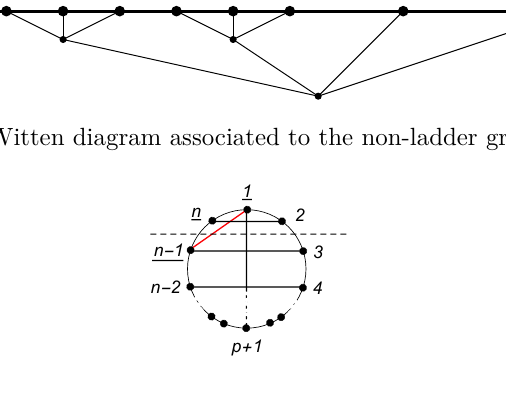
Figure 16 . n -point ladder diagram, A ( I n :1( p + 1) , 2 n, . . . , p ( p + 2)) , and its factorization contri-